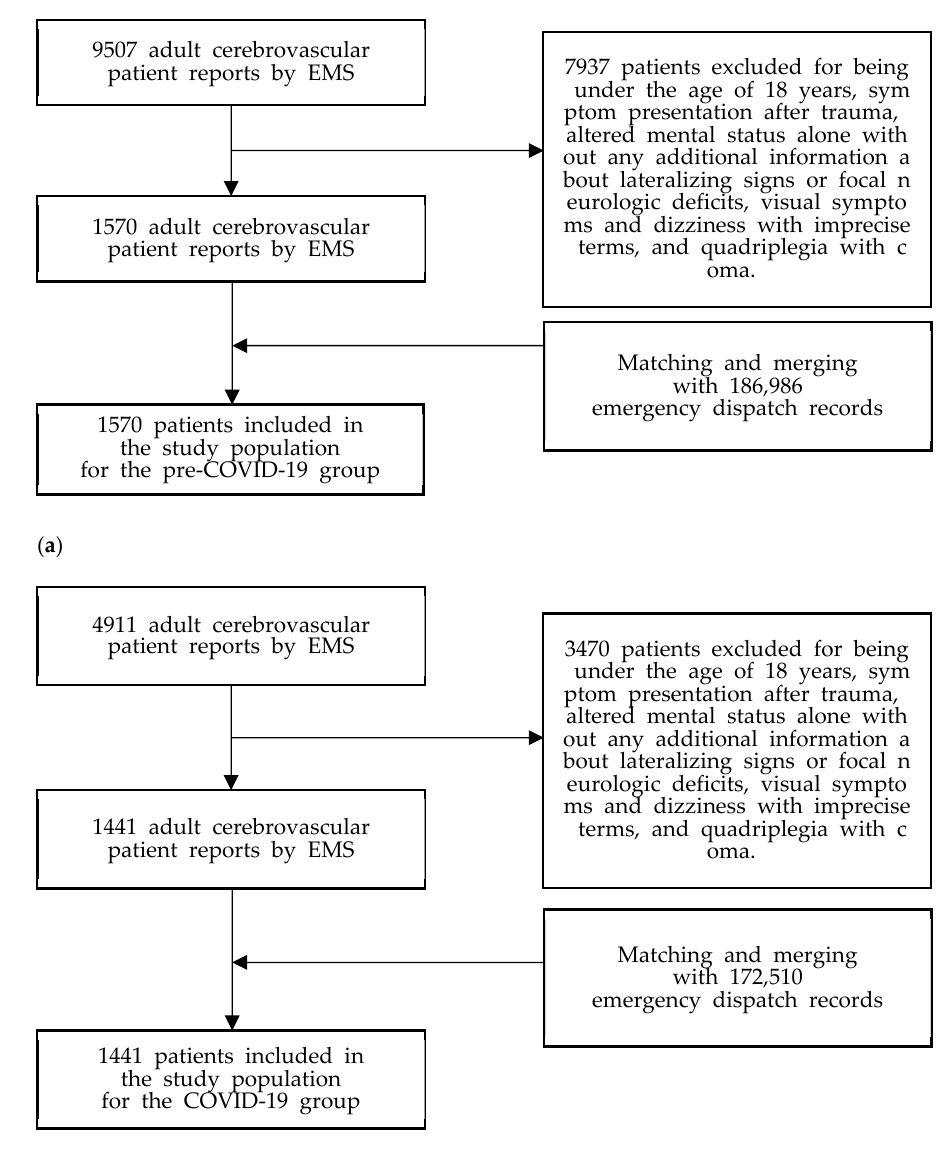
Figure 1. The flowchart of the study population. EMS; emergency medical service, COVID-19; coronavirus disease-19. ( a ) The flow chart for the pre-COVID-19 study population. ( b ) The flow chart for the COVID-19 study population.